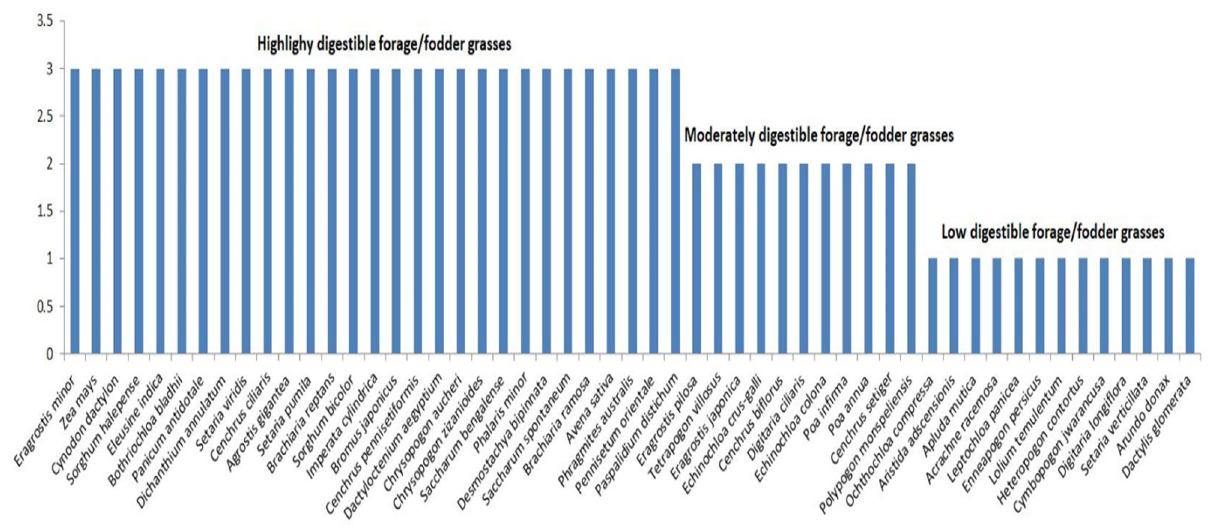
Figure 3. Clustering of ethnobotanical fodder/grasses based on their in vitro digestibility i.e. high (< 450 g/kg), medium (400–450 g/kg) and low digestible fodder grasses (> 400 g/kg). Results showing greater number of grass species (n = 29) in high digestible cluster followed by low (n = 13) and medium (n = 11) digestibility clusters.